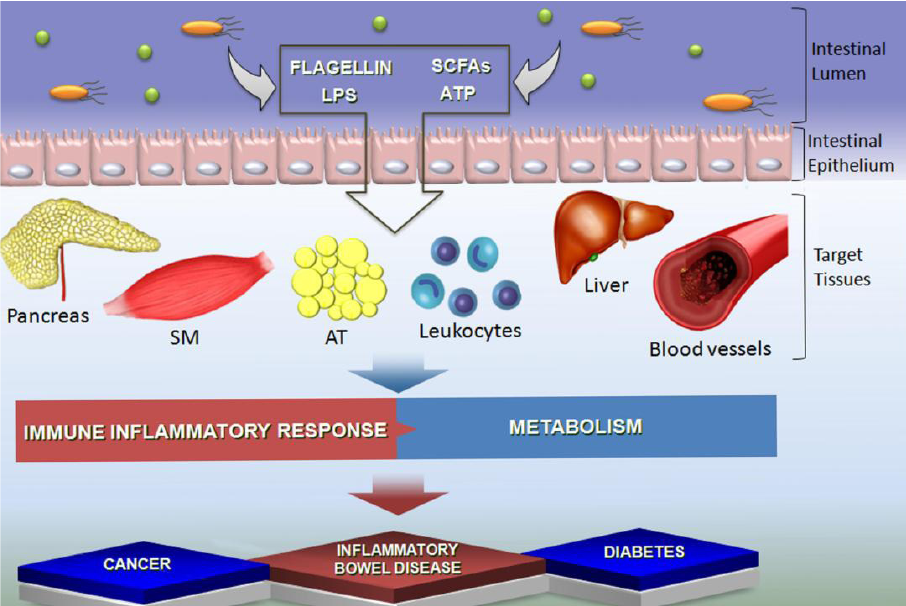
Figure 1. Schematic representation of the interaction between gut microbiota and host tissues. Soluble factors (e.g., LPS, flagellin, ATP and short chain fatty acids (SCFAs)) released by gut microbiota modulate host tissues such as pancreas, skeletal muscle (SM), adipose tissue (AT), leukocytes, liver and blood vessels function and may play a role in the development of several diseases including cancer, inflammation and